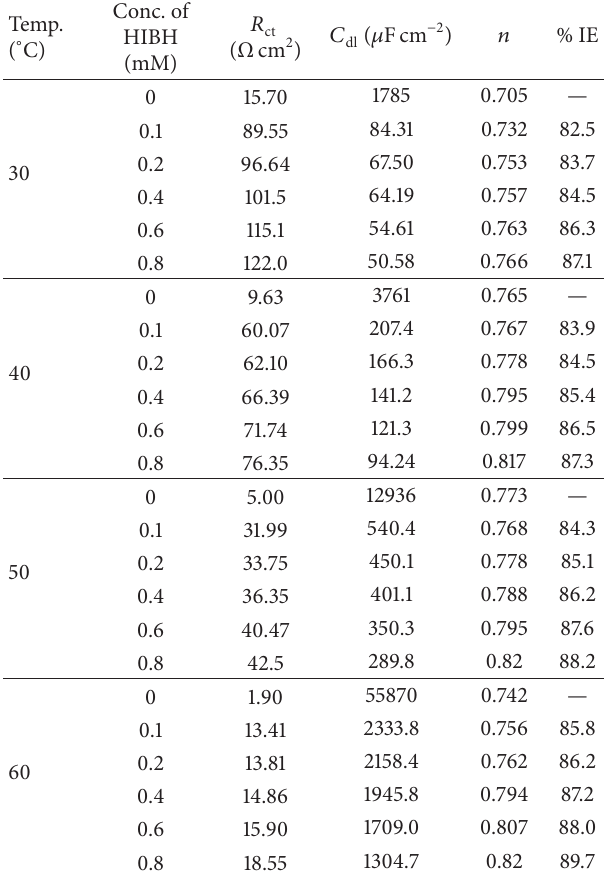
Table 3: Electrochemical impedance parameters for the corrosion of mild steel in 1M HCl in the absence and presence of inhibitor at different temperatures.